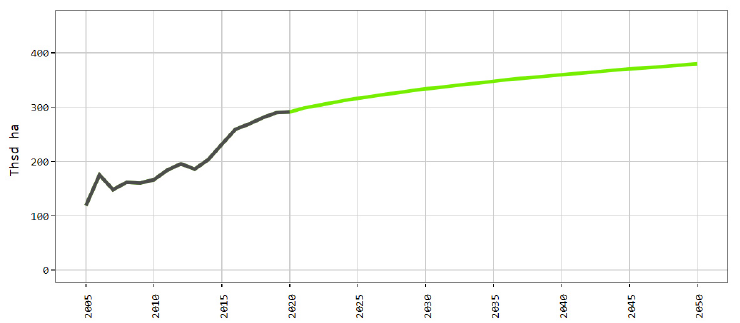
Figure 17. Utilized agricultural area in organic farming in 2005–2020, with a 2021–2050 projection for Latvia, in thousands of hectares [62].